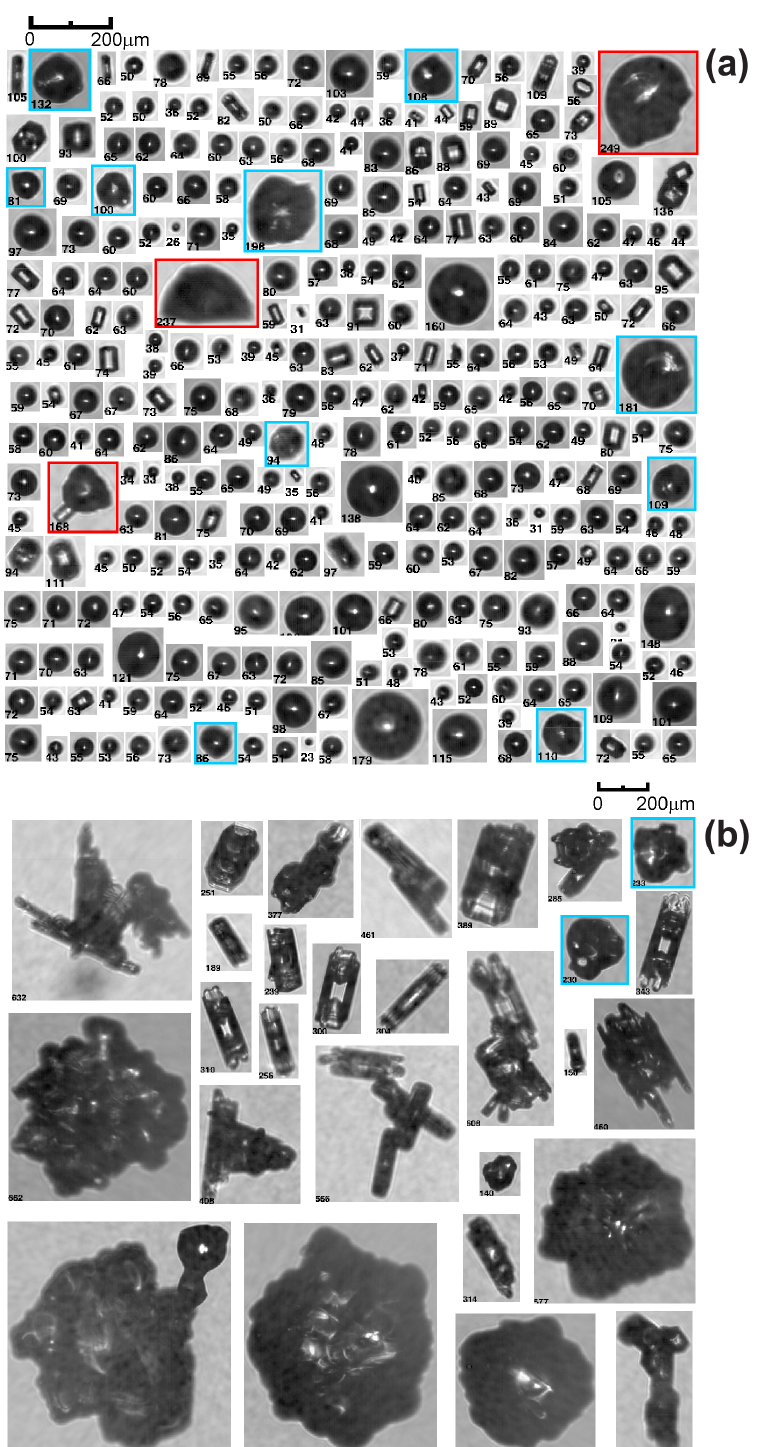
Figure 6. Spatial sequence of CPI images of (a) droplets and faceted ice crystals and (b) aged large ice particles. (a) Blue frames indicate frozen droplets with modified shapes, and red frames indicate fragments of shattered frozen drops. Numbers under each image indicate their maximum sizes ( L max ). Cloud particles in panels (a, b) are spatially mixed, and they were split between two panels because of their difference in size. The images were sampled at T a = − 5 ◦ C and H = 5650m during 09:40:42–09:40:47UTC on 15 May 2015 during measurements shown in Fig.